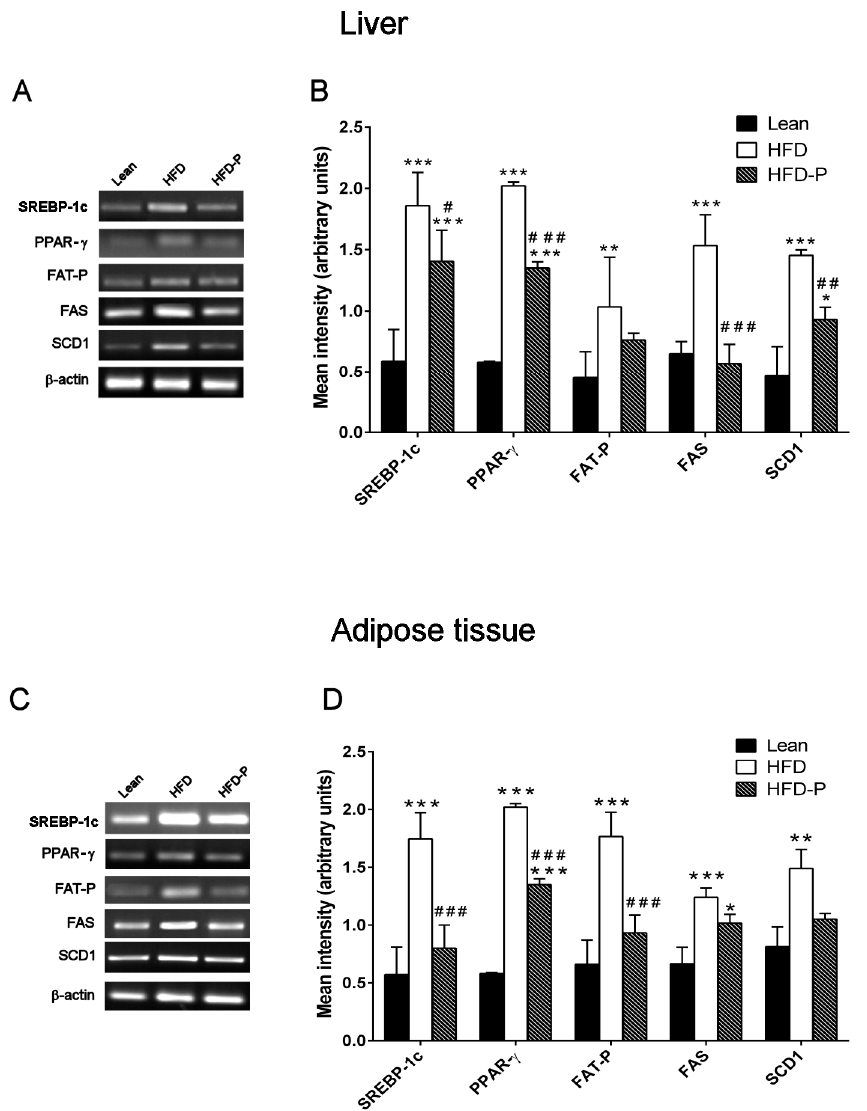
Figure 4. Effect of Pistachio consumption on lipid metabolism-related genes expression. Pistachio intake prevents the impairment of lipid metabolism-related gene expression in liver and adipose tissue. Representative images of the RT-PCR results (left panel) and mRNA levels of SREBP-1c, PPAR- ɣ , FAT-P, FAS , and SCD-1 (right panel) in the livers ( A, B ) and adipose tissues ( C, D ) of lean, HFD, and HFD-P mice ( B ). Data are the means ± S.E.M. ( n = 8/group). Asterisk denotes significant difference compared with the lean group (* p < 0.05; ** p < 0.01; *** p < 0.001); hash denotes significant difference compared with the HFD group ( # p < 0.05; ## p < 0.01; ### p < 0.001).